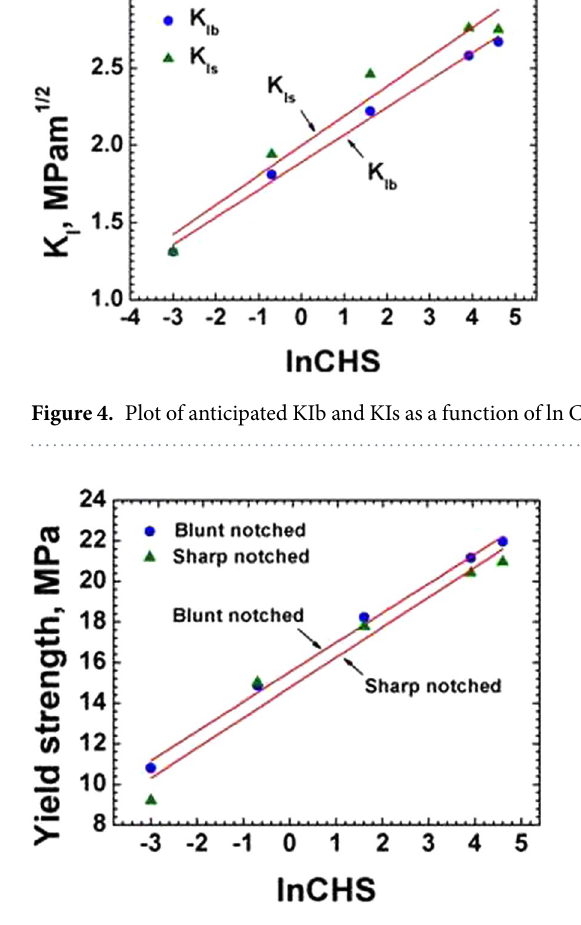
Figure 5. Yield strength of blunt notch and sharp crack specimens as a function of ln CHS at 25 °C.